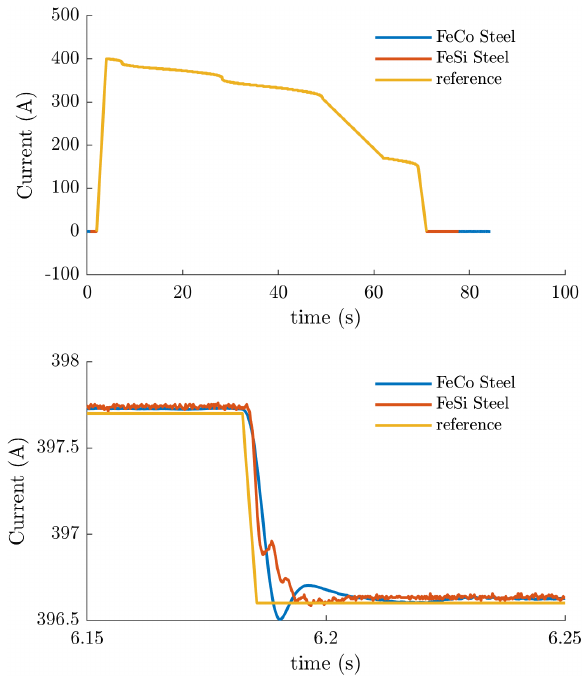
FIG. 18. Top: current cycle used for the experiment. Bottom: zoom of the current step from 6.15 to 6.25 seconds.